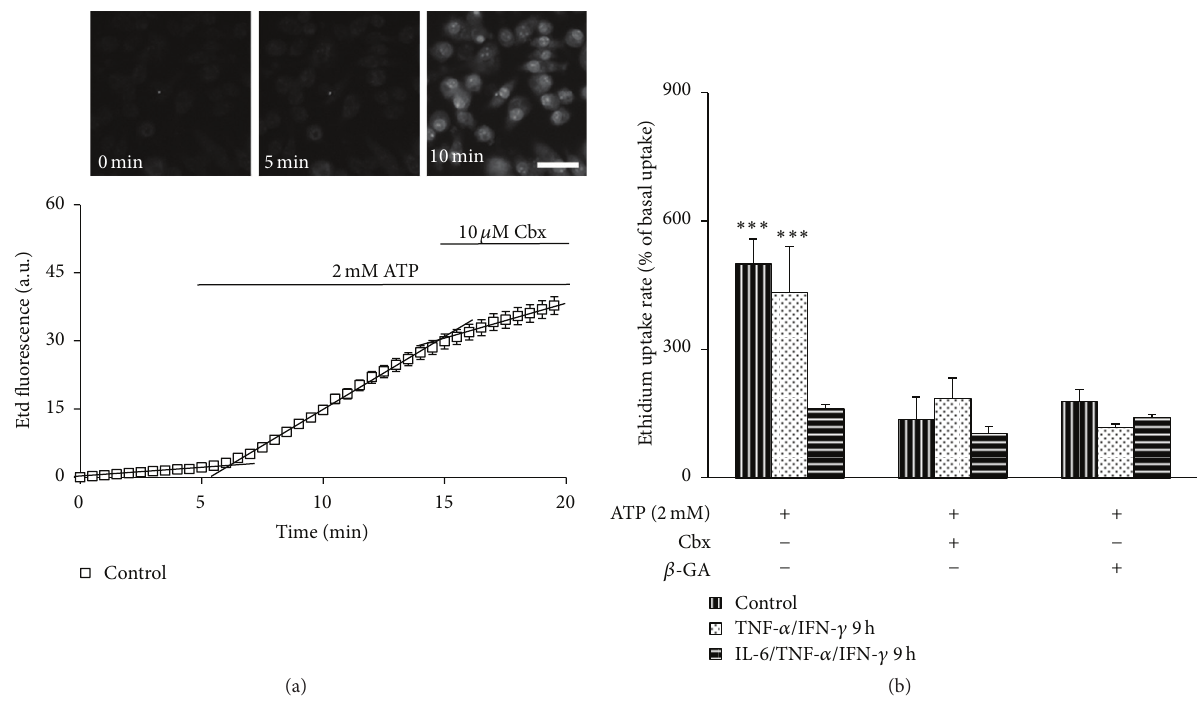
Figure 5: Extracellular ATP increases the cell membrane permeability in EOC20 cells. (a) Fluorescent views of Etd uptake of EOC20 cells cultured under control conditions before (0min) or after application of 2 mM ATP (5 and 10min). Scale bar: 25 𝜇 m. Time-lapse measurement. After5 minofbasaluptake,2 mMATPwasaddedtoextracellularsolution.At15 minofrecording,10 𝜇 Mofcarbenoxolone(Cbx)aHCblocker was added to the bath. Black lines denote the slope at different times of Etd uptake. Data represent the mean ± SEM of 30 cells in each of 5 independent experiments. (b) Graph showing the effect of acute application of extracellular ATP in EOC20 cells under control conditions or after treatment with TNF- 𝛼 /IFN- 𝛾 or with 50 ng/mL IL-6 plus TNF- 𝛼 /IFN- 𝛾 for 9h. The effect of acute blockade with 10 𝜇 M carbenoxolone (Cbx) or 50 𝜇 M 18- 𝛽 -glycyrrhetinic acid ( 𝛽 -GA) is also shown. Data was normalized to basal uptake in each condition (dashed line) and represents the mean ± SEM. ∗∗∗ 𝑃 < 0.001 versus control